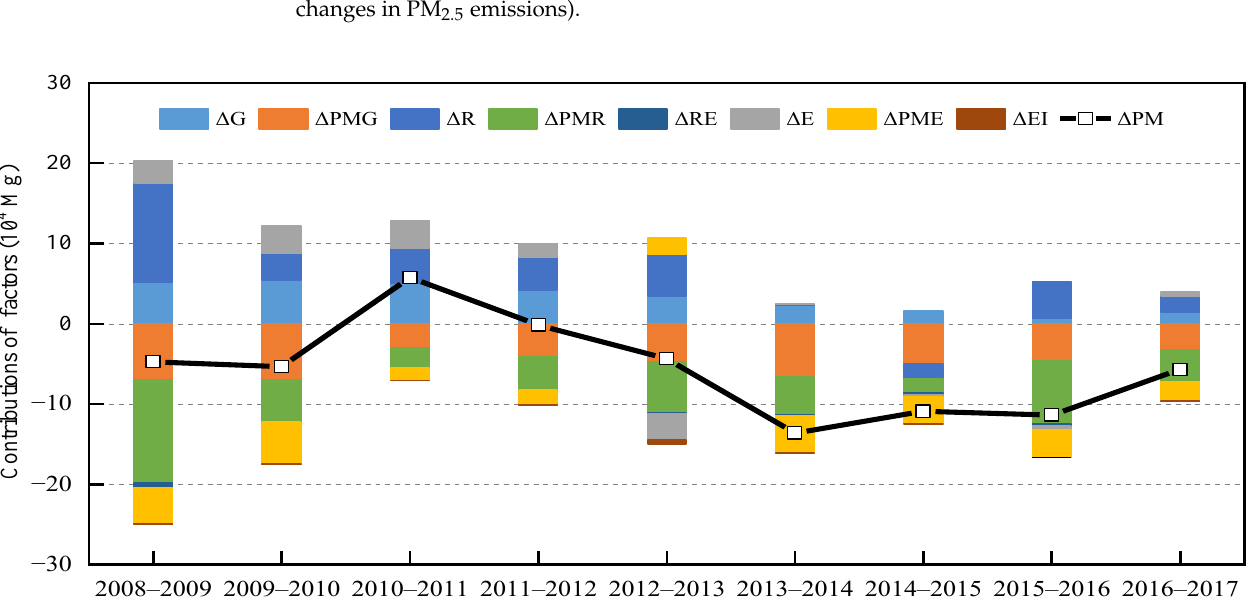
Figure A3. Decomposition results in Western China from 2008 to 2017 ( Δ G , Δ PMG , Δ R , Δ PMR , Δ RE , Δ E , ΔP ME and Δ EI denote the effects of changes in GDP, emission intensity, innovation input scale, innovation input PM 2.5 intensity, innovation input efficiency, energy consumption scale, emission coefficient, and energy intensity on the changes in PM 2.5 emissions, respectively. Δ PM indicates the changes in PM 2.5 emissions).